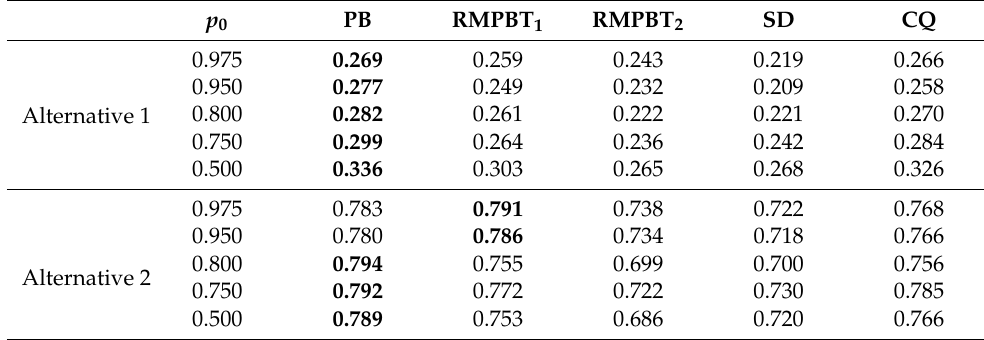
Table 3. Power analysis of 4 tests assuming the true covariance matrix is Σ = Σ 2 . n 1 = n 2 = 70 and p = 1000; RMPBT is the approach of [12], SD is the approach of [4] and CQ is the approach of [7].